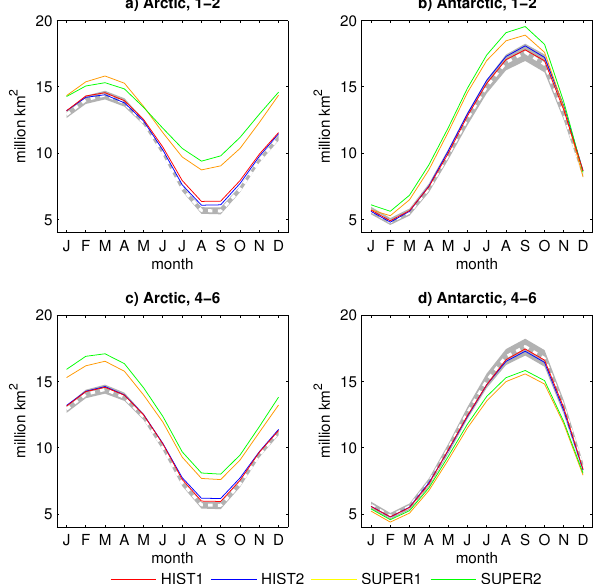
Figure 4. Ensemble-mean simulated seasonal evolutions of hemi- spheric sea-ice area for integration years 1–2 (a, b) and 4–6 (c, d) for the two historical and the two supervolcano ensembles. Gray shading and the dashed white line represent the 98% range and the mean, respectively, for signal occurrence in the control run. The sig- nal in the control run corresponds to the annual evolution averaged over three randomly chosen consecutive years for a 10-member en- semble.